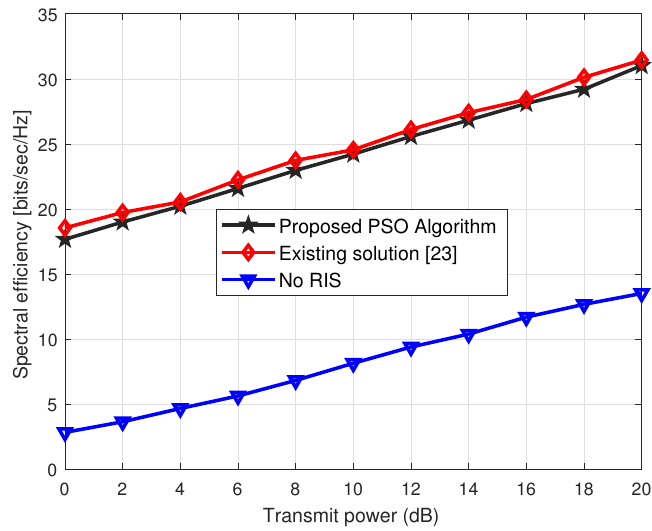
Figure 5. Spectral efficiency performance vs. transmit power (dBs) for N =